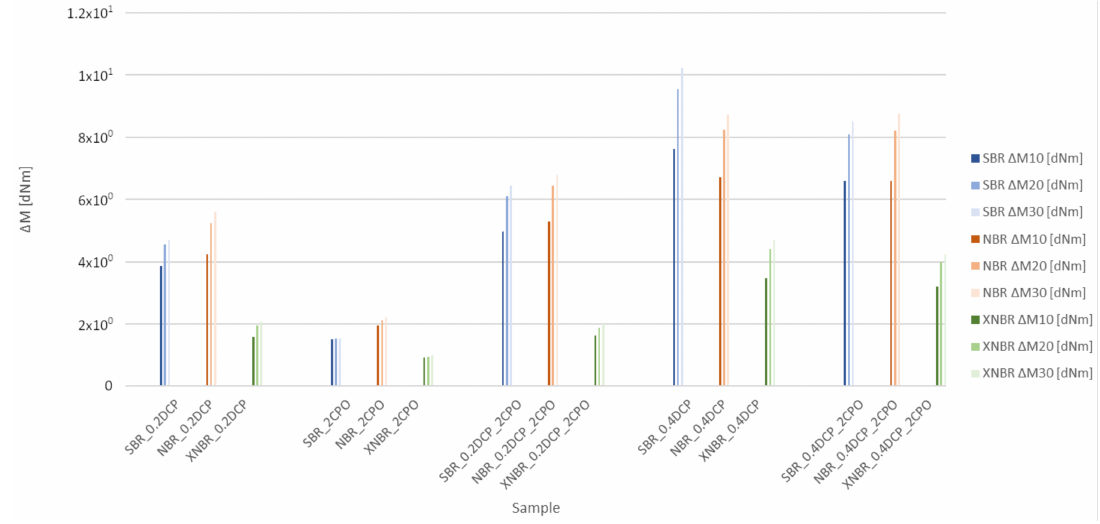
Figure 1. Vulcametric torque increase ( ∆ M) for the compounds studied at 10, 20 and 30 min from the beginning of vulcan-